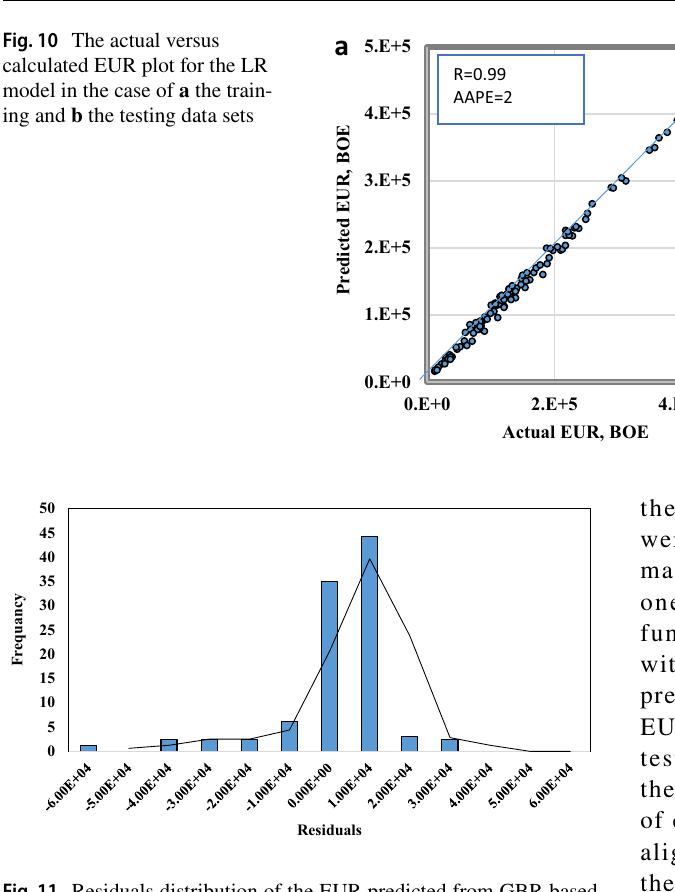
Fig. 11 Residuals distribution of the EUR predicted from GBR-based model